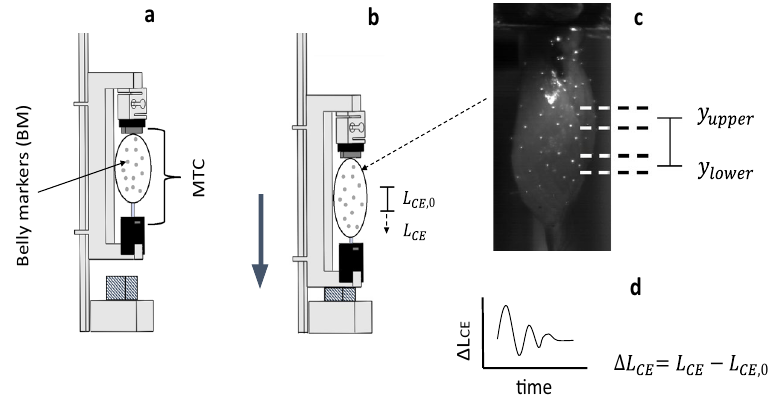
Figure 6. Drawing of the experimental setup. ( a ) The frame before TD. GAS is fixed between the upper and lower clamp (solid dark-grey rectangles). Above the upper clamp is an insulator (solid, black rectangle) and the force transducer, respectively, which are both fixated to the frame backbone (squared C-shape). The solid, black insulators prevent muscle stimulation to interfere with the force transducer. The light-grey spots on the muscle belly are illustrating the steel markers that pattern the muscle belly, which we used to calculate the dynamic force change between MTC ends in response to the impact ( (cid:31) F with m being the GAS mass, BM the arithmetic mean of all belly markers’ vertical ( y ) positions and a COM the correspondingly estimated acceleration of the centre of mass. ( b ) The frame after TD with the polystyrene (hatched rectangle) being compressed. In ( b ), the belly’s stretch response to the impact is drawn exaggerated. ( c ) A video frame image of the muscle belly from one of the trial cameras, where the white spots are the steel markers, and the dashed, black lines are the upper and lower limits of the horizontally spread upper and lower ranges of CE markers for which y upper and y lower , respectively, symbolise the arithmetic means of the vertical marker positions in each the upper and the lower range, with L CE length fixed at TD. ( d ) an example of how (cid:31) L CE changes over time, after TD. A more detailed description of the functionality of the frame is given elsewhere 14